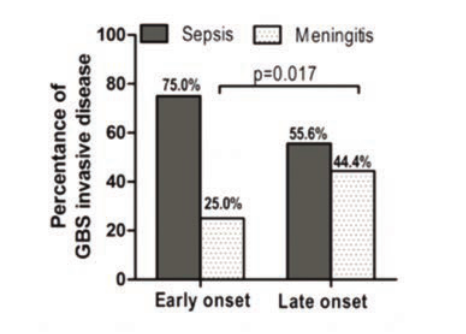
Figure 2. Group B Streptococcus (GBS) rates of early onset dis- ease (EOD), late onset disease (LOD) and total rates of GBS inva- sive disease in infants less than 90 years old between the decades 1995-2005 and 2006-2016 in Crete, Greece. Boxes show 5–95 percentiles, horizontal line represents median, and whiskers rep- resent minimum and maximum. *P<0.05.